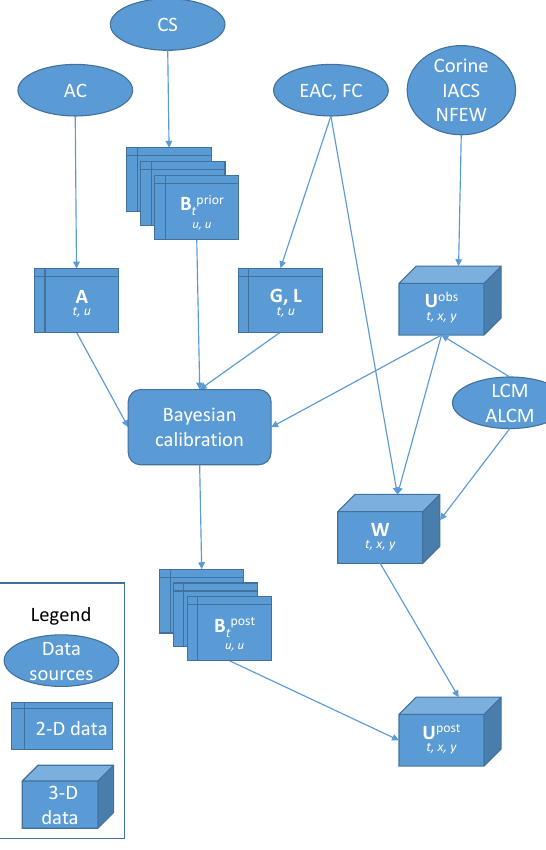
Figure 2. Schematic diagram showing information flow in the data assimilation procedure. Data sources are listed in Table 1. The prior estimate of the transition matrix B at each time point is provided by the CEH Countryside Survey (CS). Observations of the area ( A ) occupied by each land-use type u , the gross gains and losses( G and L ), and spatially explicit estimate of land use ( U obs ) are combined in a Bayesian calibration via the likelihood functions (Eqs. 5–7) to produce updated, posterior estimates of the transition matrix B post . We then use spatial and probabilistic information on the location of land-use change ( W ) to simulate posterior realisations of land use and land-use change ( U post